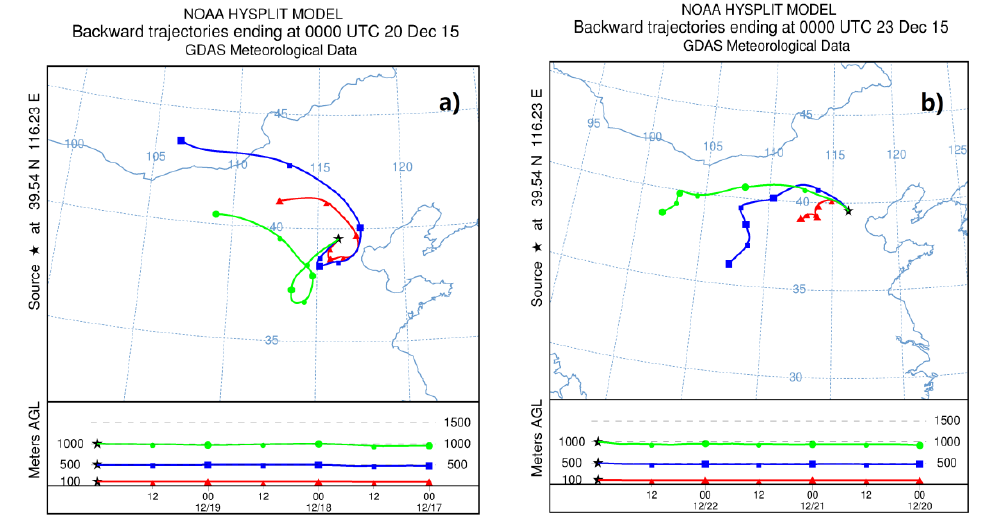
Figure 13. The 72-h backward air trajectories arriving at three heights in Beijing at ( a ) 0800 LT 20 December and ( b ) 0800 LT 23 December (HYSPLIT model).